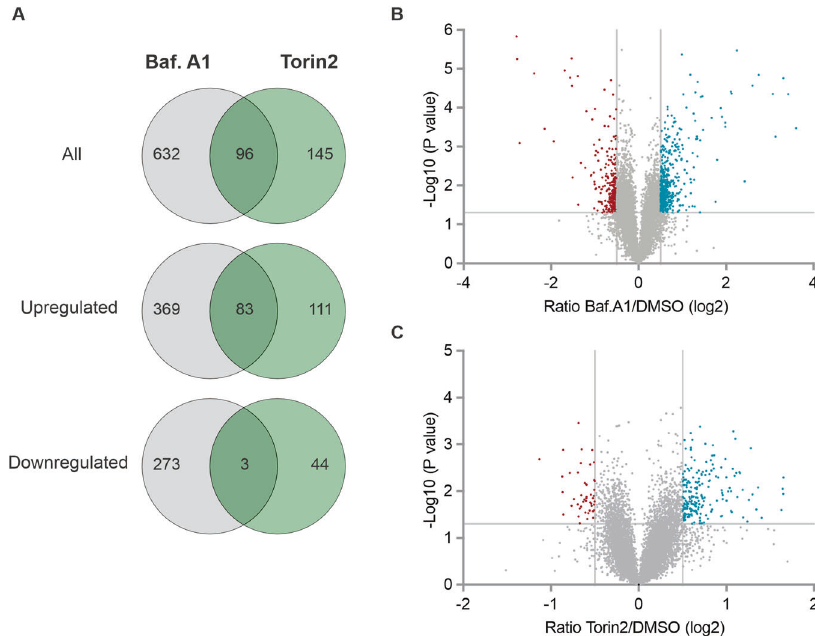
Fig. 3 Changes in cellular proteome upon modulation of autophagy. LN-229 cells were exposed to 0.1 % hypoxia as well as serum- and glucose-starvation for 6 h and were treated with torin2 (100 nM) or ba fi lomycin A1 (100 nM). A Overlap of proteins signi fi cantly deregulated (fold change ≥ 0.5 or ≤ − 0.5; p < 0.05) by torin2 or ba fi lomycin A1. B , C Volcano plot showing fold change versus p -value for ba fi lomycin A1 (B) or torin2 (C) versus